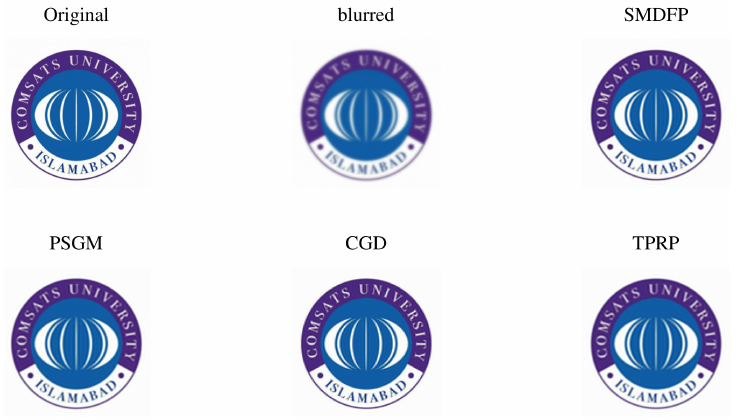
Figure 5. Comparison of the original image, blurred image, SMDFP image, CGD image, PSGM image, and TPRP image for the number of iterations, CPU time, MSE, and SNR.